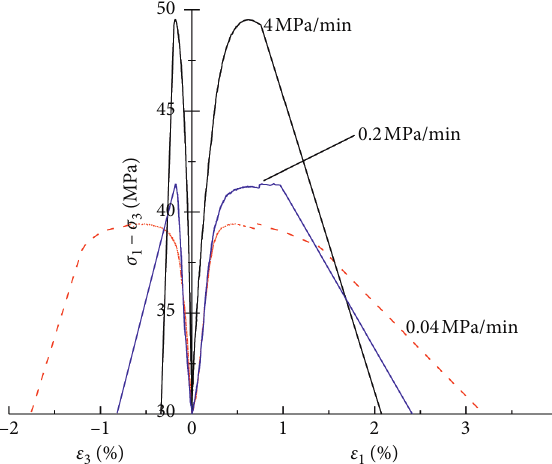
Figure 9: Stress-strain curves of frozen sandstone under different unloading rates (–10 ° C, σ 0